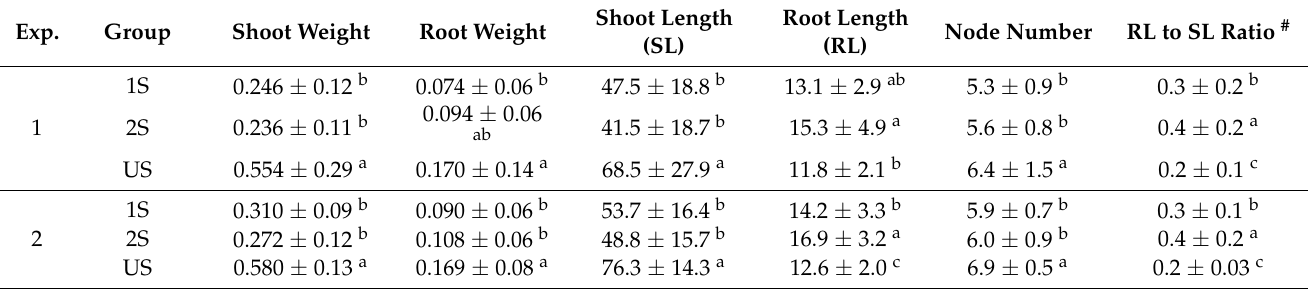
Table 1. Growth parameters of the drought-treated soybean plants.